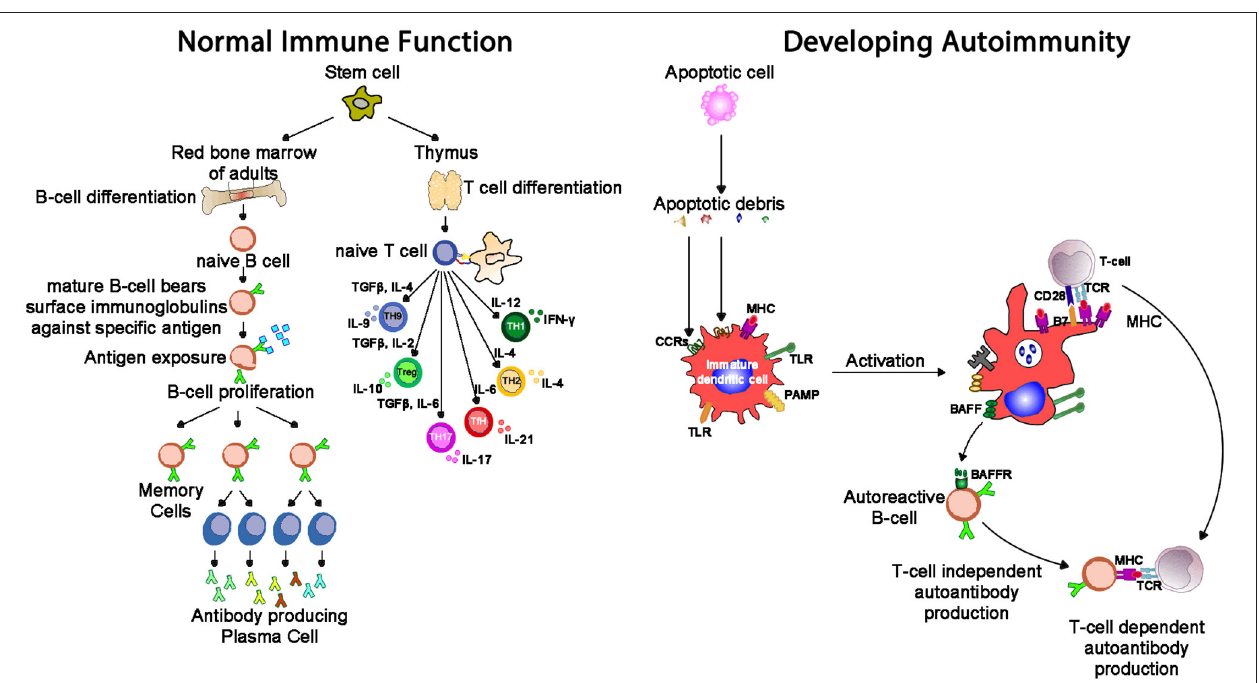
FIGURE 7 | Whereas, normal immunity is marked by tolerance to self-structures (mediated by central and peripheral regulatory pathways), autoimmunity results from aberrant activation of autoreactive T and B cells, responsible for inflammation seen in autoimmune diseases. One mechanism of tolerance breakdown shown in the figure involves impaired clearance of apoptotic debris. IL-2, interleukin-2; IL-4, interleukin-4; IL-6, interleukin-6; IL-9, interleukin-9; IL-10, interleukin-10; IL-17, interleukin-17; TGF- β , transforming growth factor-beta; PAMP, pathogen-associated molecular pattern; TLR, toll-like receptor; MHC, major histocompatibility complex; TCR, T cell receptor; CCR, C-C chemokine receptors; BAFF, B cell activating factor; BAFF-R, B cell activating factor